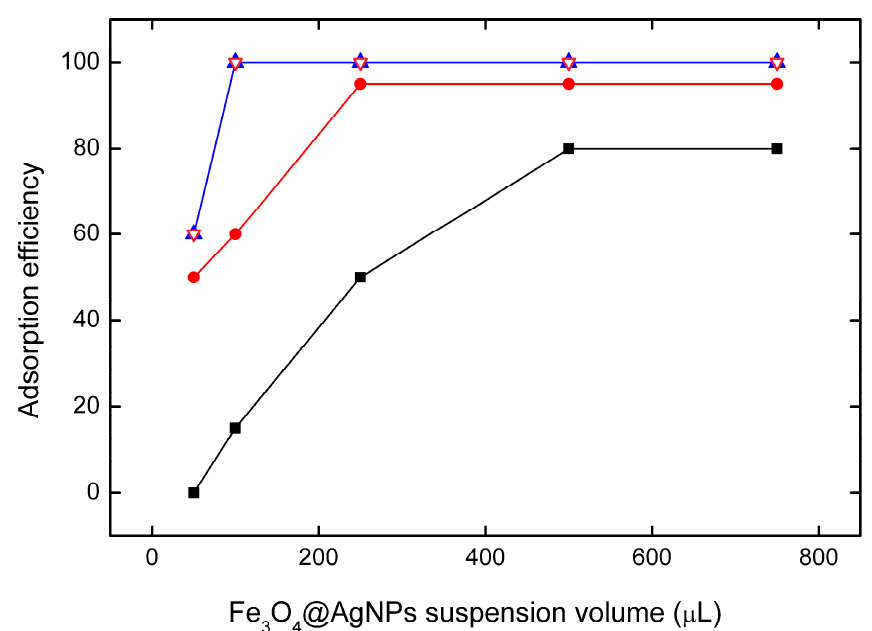
Figure 6. Dependence of the adsorption efficiency on the adsorbent (Fe 3 O 4 @AgNPs) suspension volume for nitrate concentrations equal to 50 mg L − 1 (black squares), 10 mg L − 1 (red dots), 5 mg L − 1 (blue triangles) and 2 mg L − 1 (magenta empty inverted triangles).